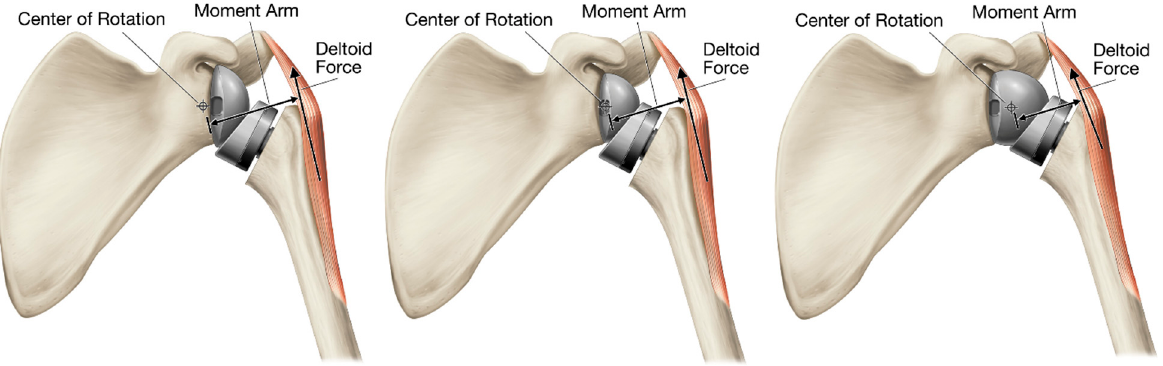
Figure 4. Increase in deltoid abductor moment arm length by medializing the CoR: inset CoR gleno- sphere ( left ), standard offset glenosphere ( middle ), and expanded glenosphere ( right ).